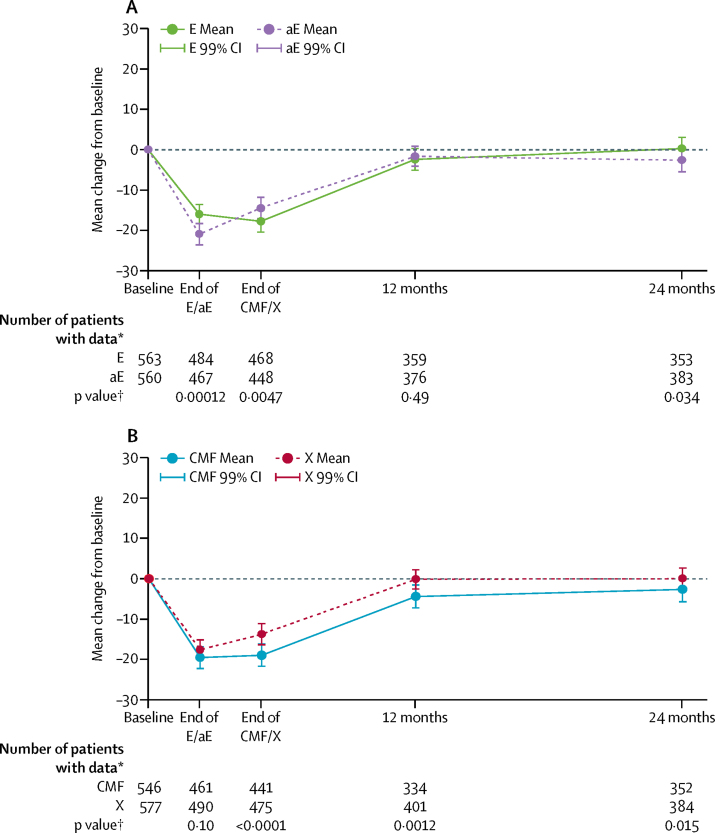
Mean change in scores on the EORTC QLQ-C30 global health status quality-of-life scale from baseline. by treatmentEORTC=European Organisation for Research and Treatment of Cancer. E=standard epirubicin. aE=accelerated epirubicin. CMF=cyclophosphamide, methotrexate, and fluorouracil. X=capecitabine. *At baseline and all timepoints of interest. †p value from ANCOVA analysis of E versus aE and for CMF versus X, adjusted for baseline subscale score.